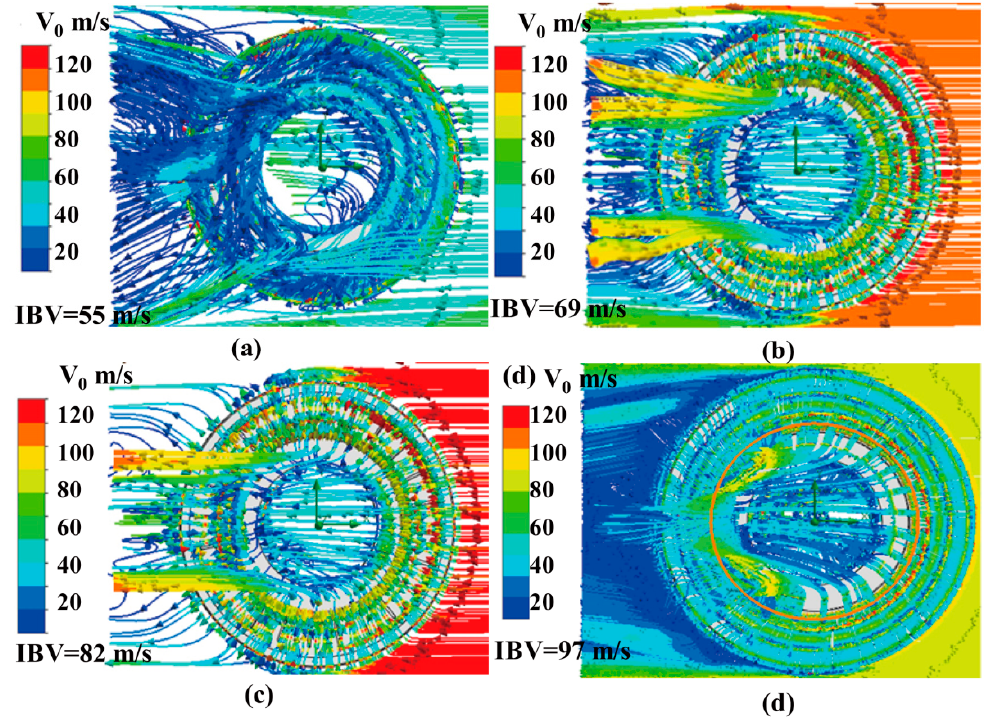
Figure 9. Schematic diagram of brake ring and powder metallurgy pins used for the sub-scaled test.